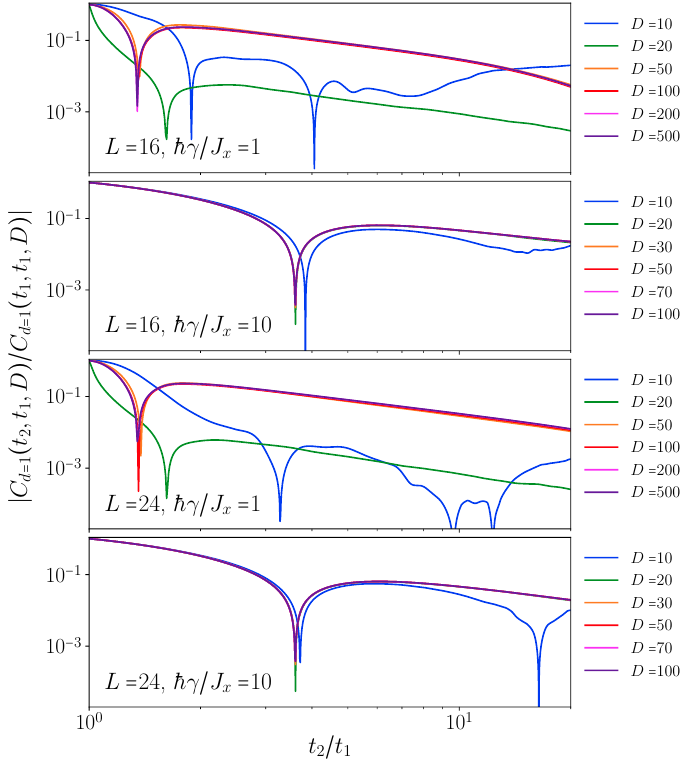
Figure 11: Convergence of the purification approach for spin- 1 / 2 chains of different / J = 2. We chose a vanishing trun- length L , different dissipation strengths and J z x cation goal (cid:34) = 0 to enforce the realization of the bond dimension D and use a time / (cid:126) = 0.05 and t / (cid:126) = J step ∆ tJ x x 1